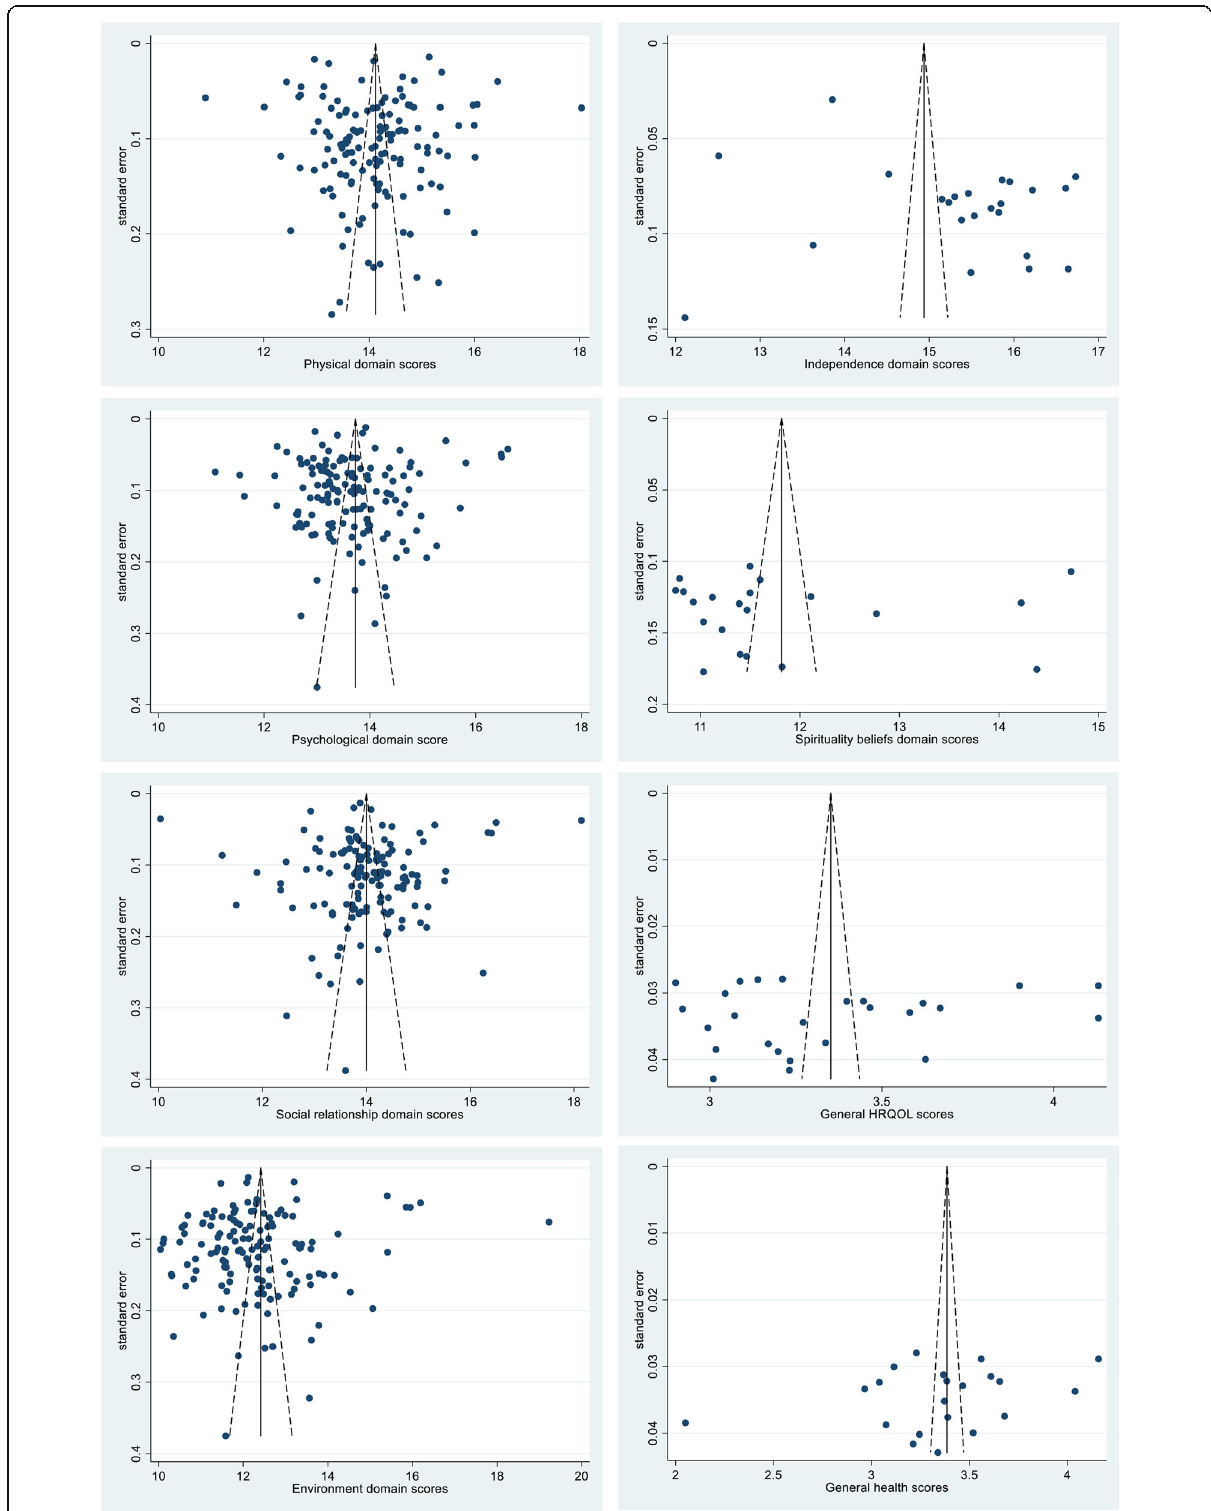
Fig. 3 Funnel plots for selected indicators of HRQOL, China,